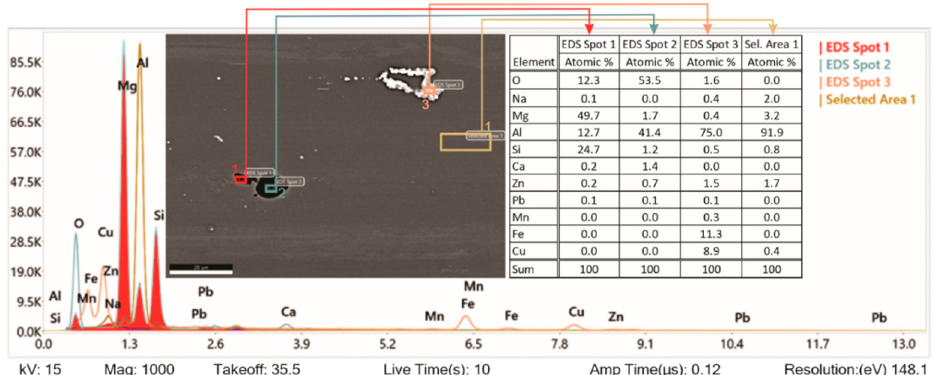
Figure 8. SEM image and EDS analysis of tested aluminium alloy.